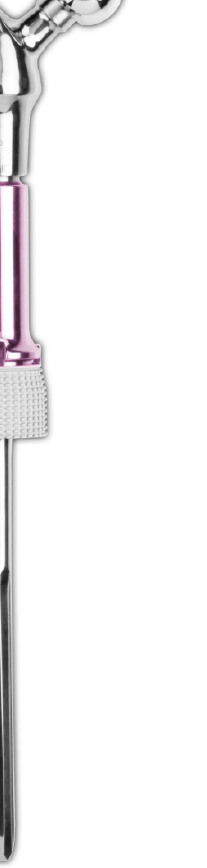
Figure 5. Agulna ® silver coating (Stryker, Newbury, UK)—an example of active surface modifica- tion.